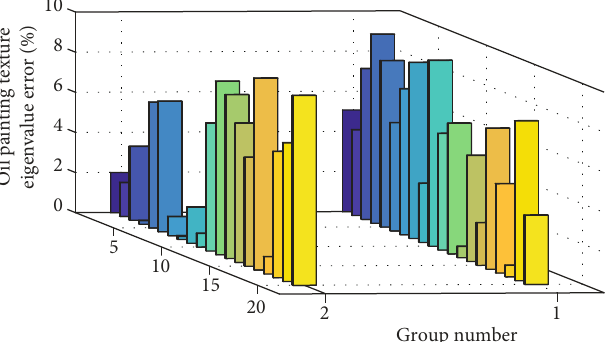
Figure 8: Three-dimensional histogram distribution of oil painting texture eigenvalue